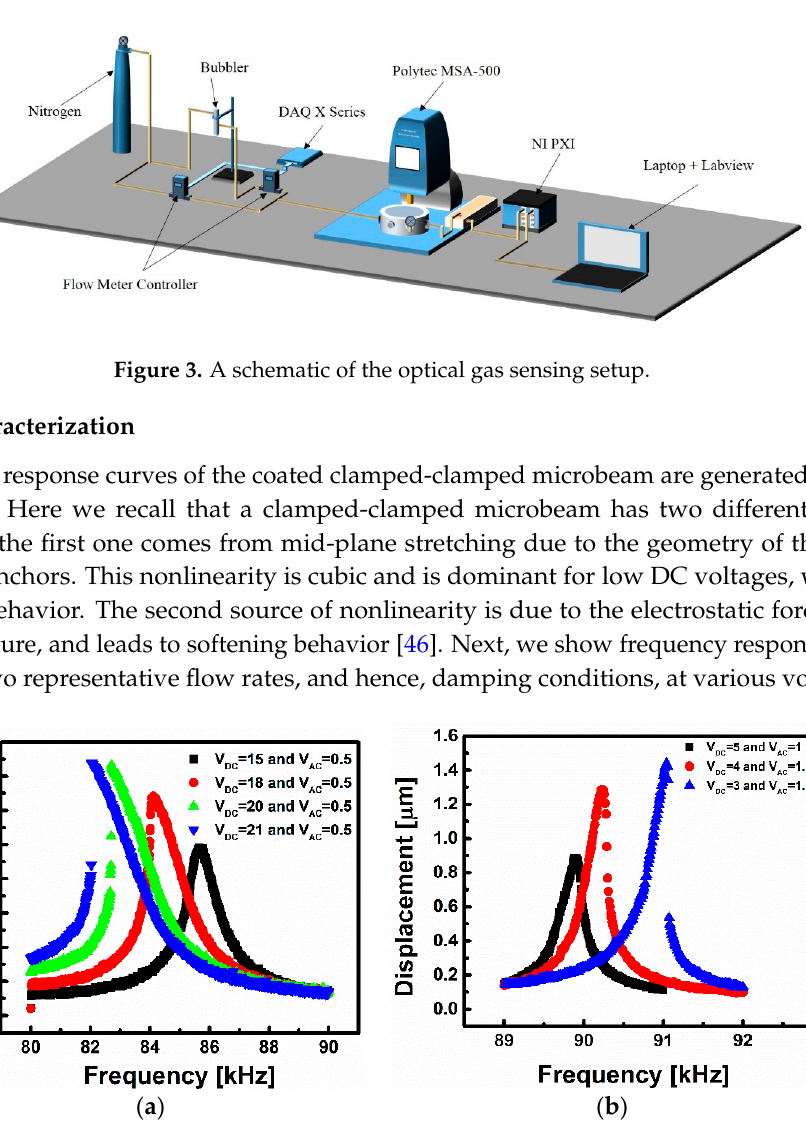
Figure 3. A schematic of the optical gas sensing setup.